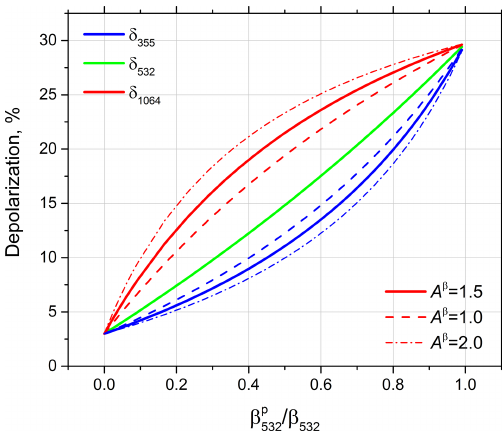
Figure 2. Depolarization ratios at 355, 532 and 1064nm as a func- tion of pollen contribution to the total backscattering coefficient β p 532 . Depolarization ratios of pollen ( δ p ) and background aerosol β 532 ( δ b ) are assumed to be spectrally independent ( δ p = 30% and δ b = 3%). The backscattering coefficient of pollen is spectrally in- dependent. The backscattering Ångström exponents of background aerosol were assumed to be the same for both pairs of wave- = A β ), and results are shown for the val- lengths ( A β 355 / 532 532 / 1064 ues A β = 1.0, 1.5 and